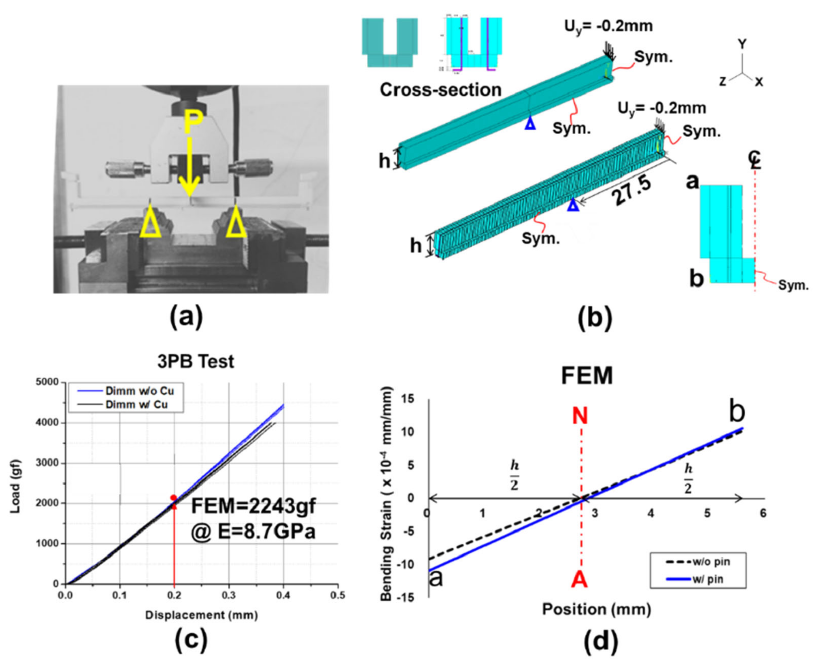
Figure 8. ( a ) Three-point bending test for a socket, ( b ) FEM modelling of the test, ( c ) determination of effective elastic modulus from load–displacement curves obtained by the test and FEM simulation, and ( d ) bending strain distributions across the thickness of the socket with and without Cu pins from the FEM simulation. Moreover, typical strain data from the front and back gauges located at the neutral axis of a socket during the second, third, and fourth thermal loading cycles were obtained